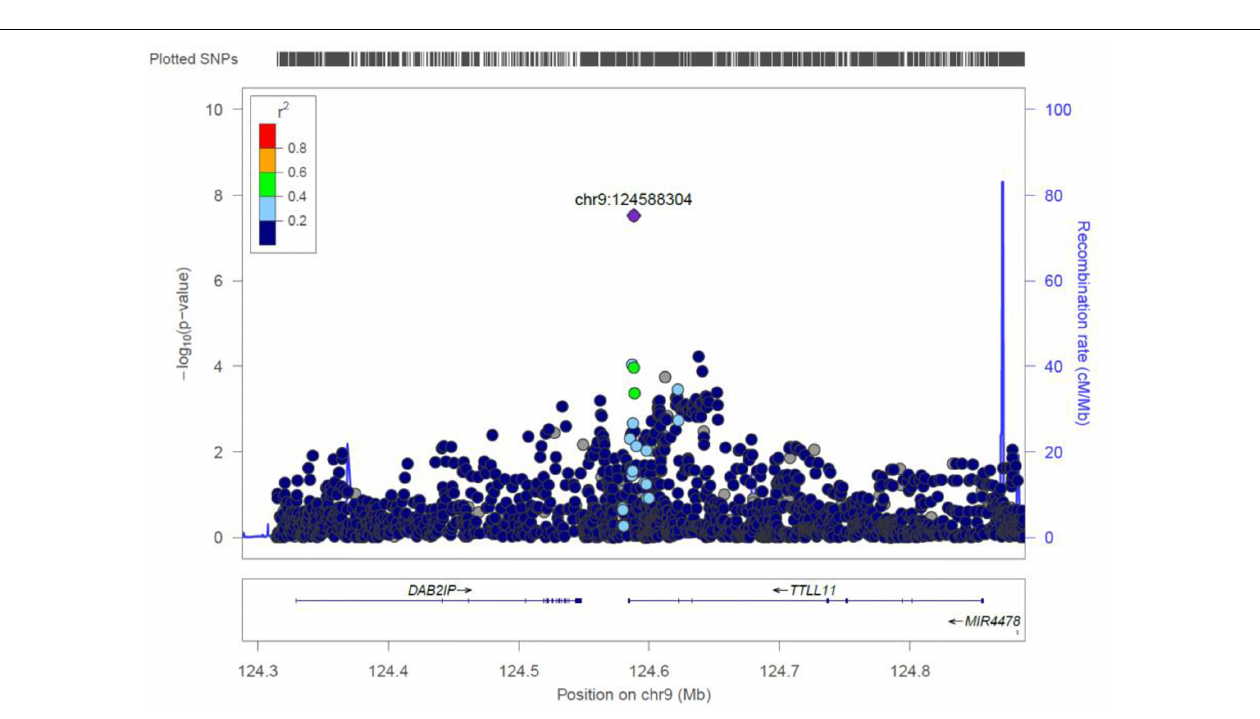
Frontiers in Genetics |